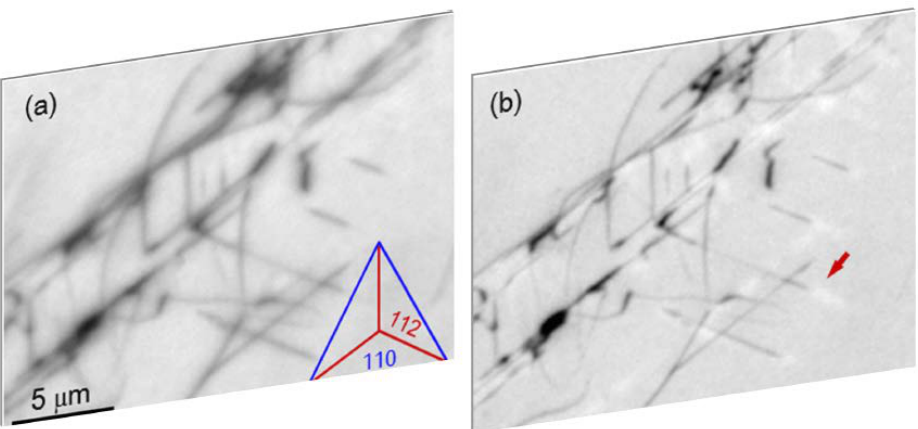
Figure 63. EBIC images of dislocations in SrTiO 3 (0.01%Nb) at zero bias ( a ) and at − 2 V ( b ). All the dislocations exhibited dark EBIC contrast at zero bias. When applying bias, bright contrast appeared in the vicinity of some straight lines with the directions along <112>. Adapted from [241].